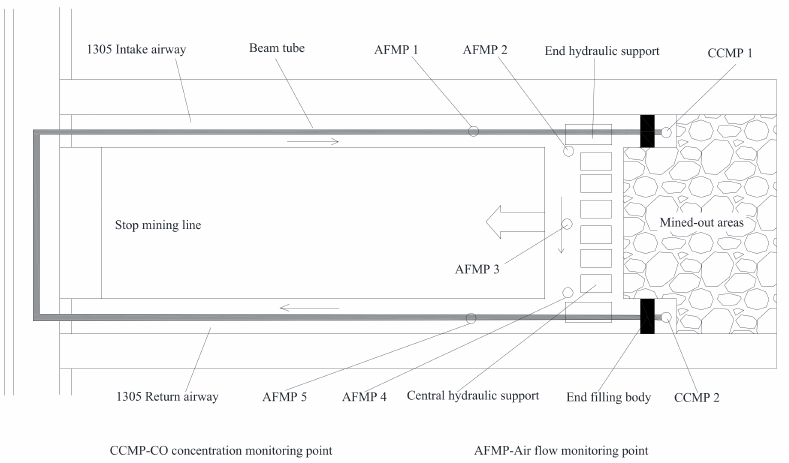
Figure 13. The arrangement of the monitoring points for the CO concentration and airflow in the working